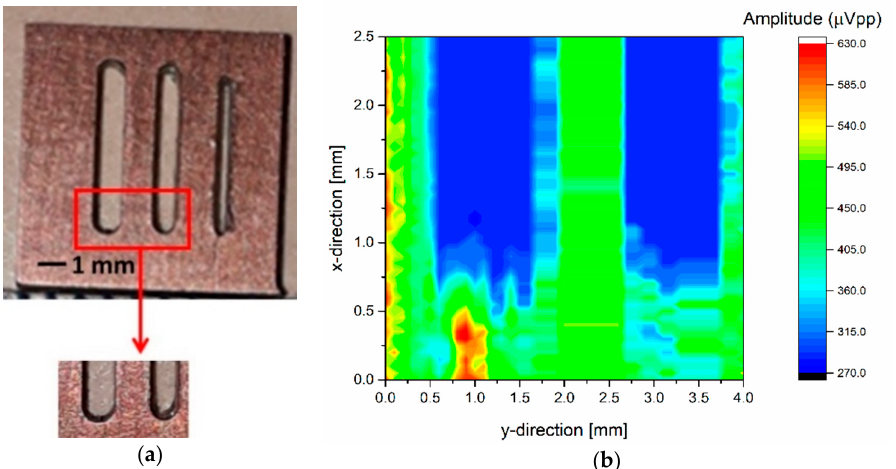
Figure 17. Set-up for acoustic characterization using an FC-70: ( a ) the schematic set-up; ( b ) an optical image of the experimental set-up using a grating phantom. Sensors 2020 , 20 , x FOR PEER REVIEW